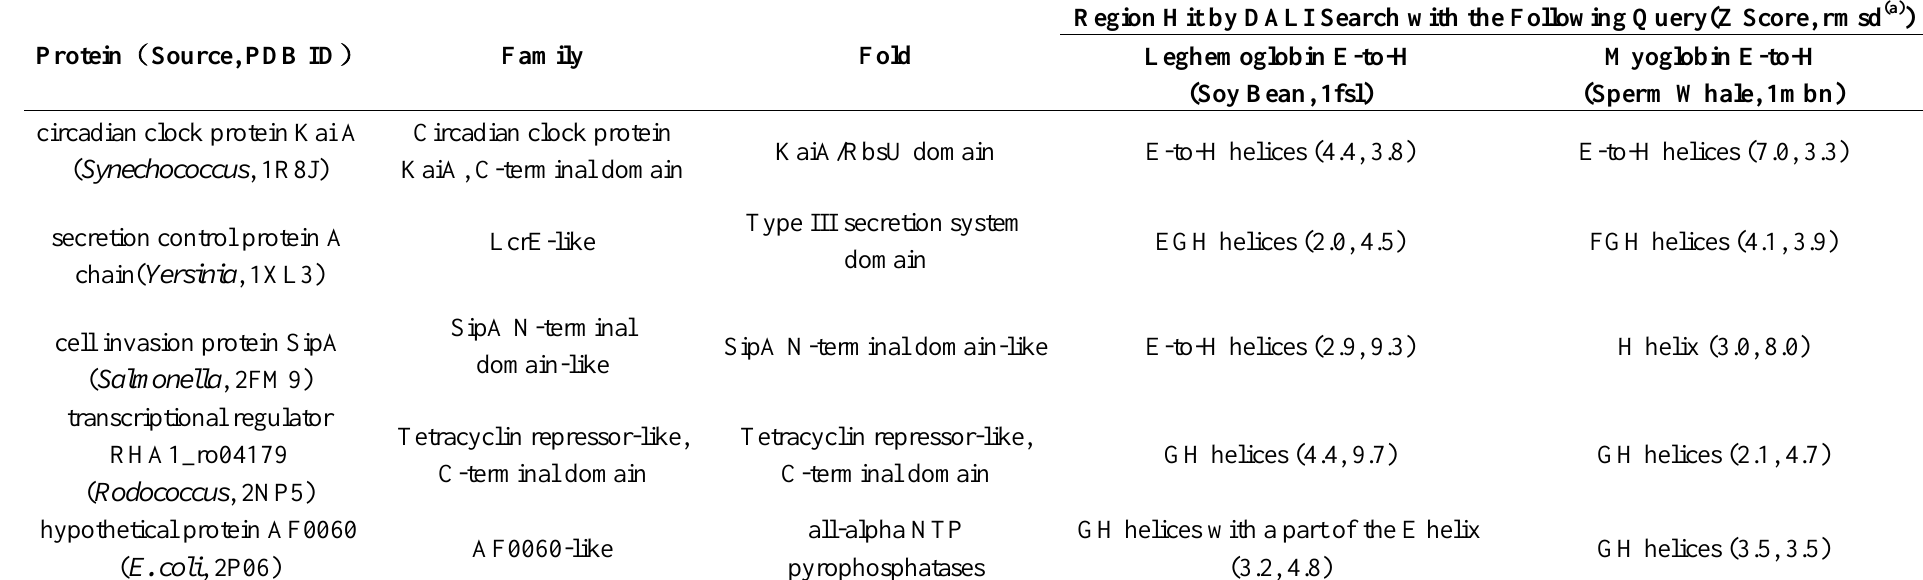
Table 1. Proteins obtained in the present